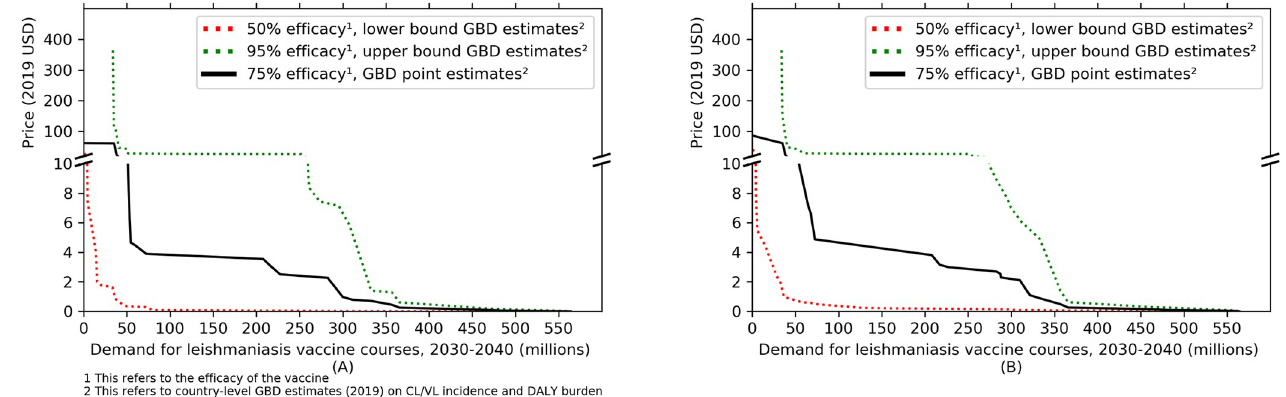
Fig 1. Illustrative global demand curve for a leishmaniasis vaccine between 2030 and 2040: (A) assuming treatment coverage = 0%, (B) assuming treatment coverage = 100%.